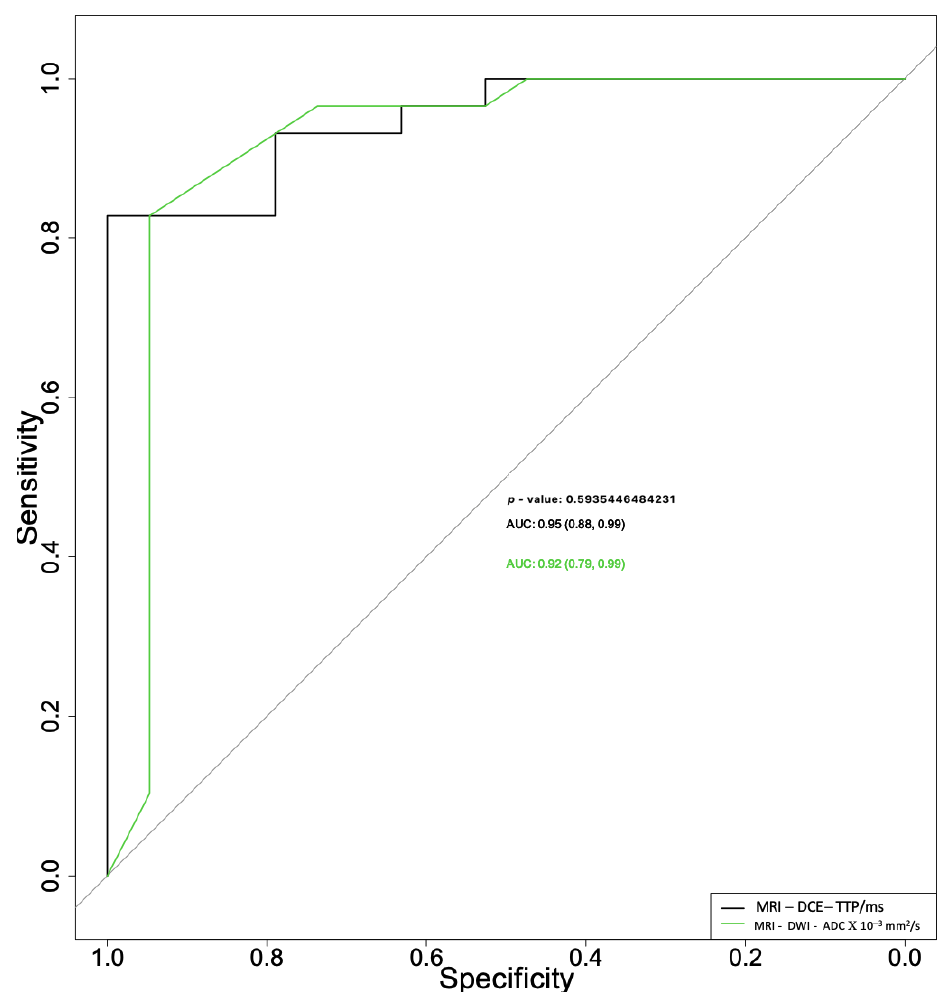
Figure 2. Receiver operating characteristic curves for apparent diffusion coefficient (ADC) and time to peak (TTP) parameters used for differential diagnosis between pleomorphic adenomas and Warthin tumors.